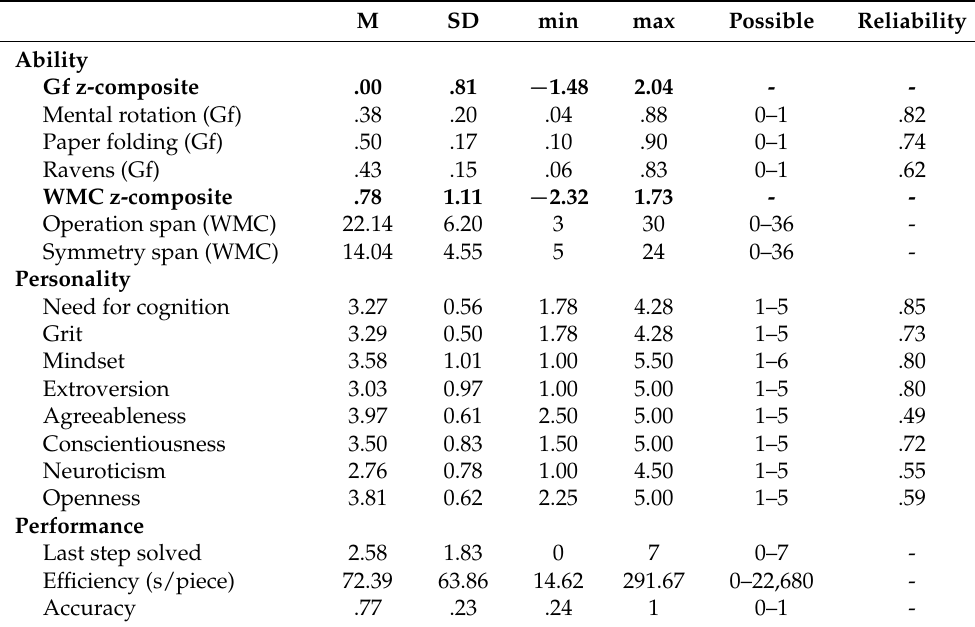
Table 2. Descriptive statistics for personality and ability.